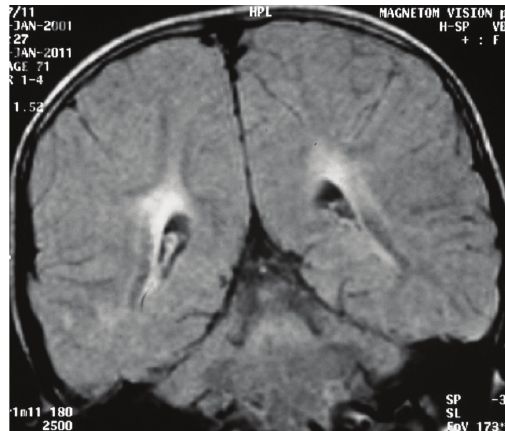
Figure 2: Magnetic resonance imaging of the brain (fluid attenuated inversion recovery sequence, coronal section) showing periventricular hyperintensities involving bilateral parieto-occipital white matter (Case 1).